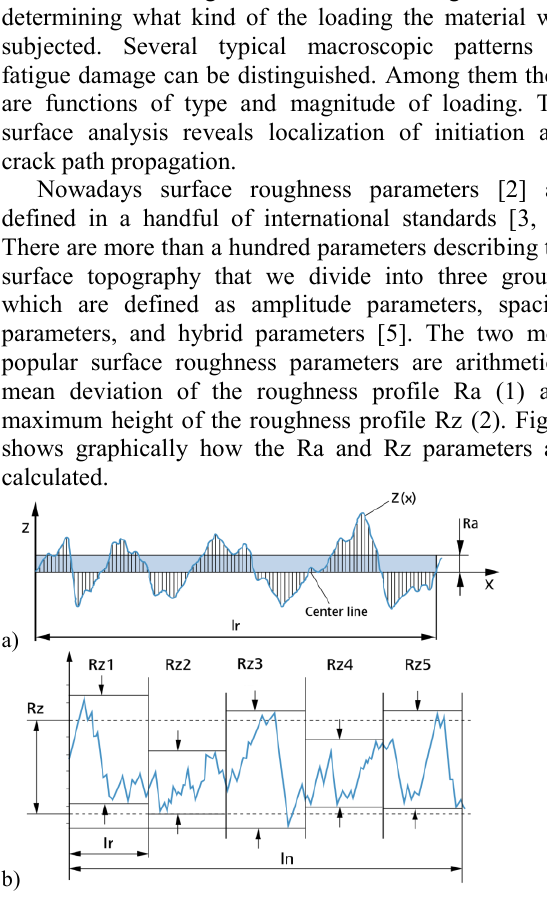
Fig. 1. The surface profiles and the method for calculating parameters a) Ra, b) Rz